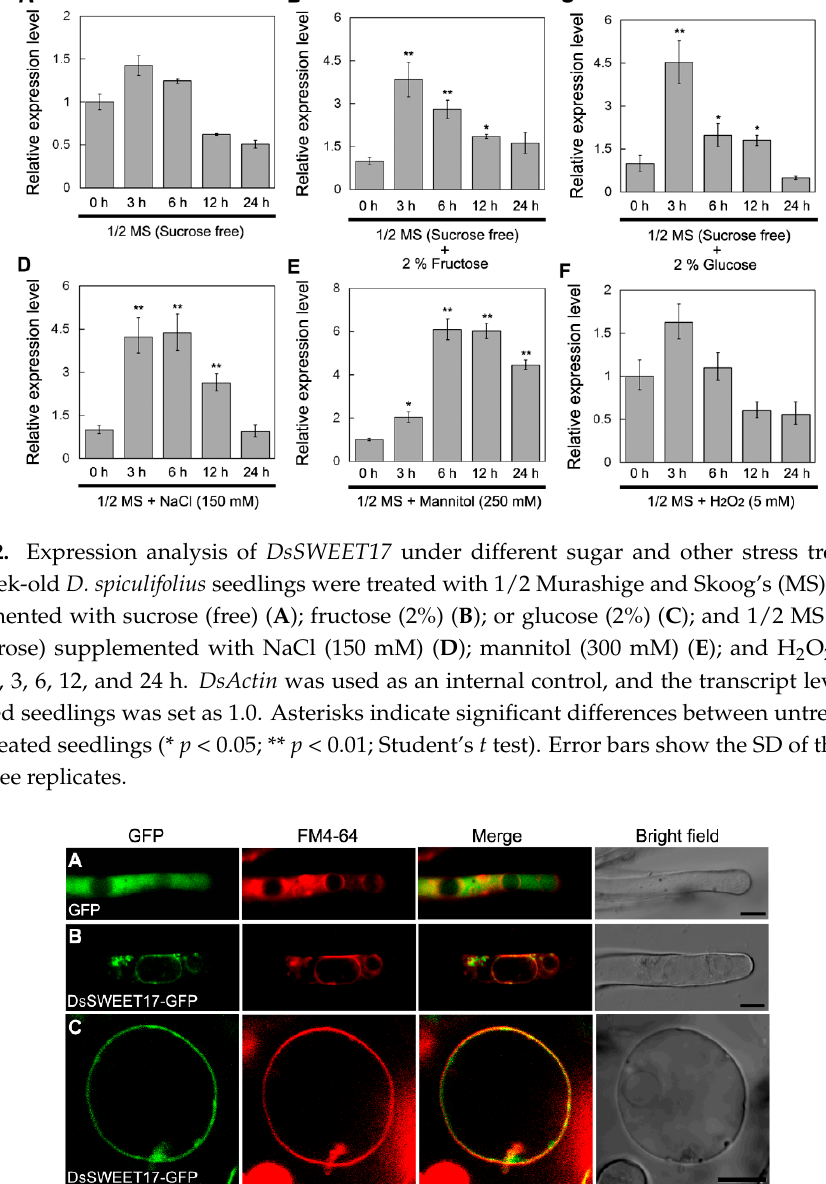
Figure 3. Colocalization of DsSWEET17-GFP with vacuolar membrane marker dye FM4-64 in Arabidopsis . Arabidopsis root hairs stably expressing green fluorescent protein (GFP) ( A ) or DsSWEET17-GFP ( B ) and intact vacuole isolated from root cells of transgenic Arabidopsis seedlings expressing DsSWEET17-GFP ( C ) were incubated for 30 ( A , B ) or 1 ( C ) min with 4 μ M FM4-64. GFP fluorescence is green, and FM4-64 is red. Merge was created by merging the GFP and FM4-64 fluorescent images. Scale bars = 10 μ m.